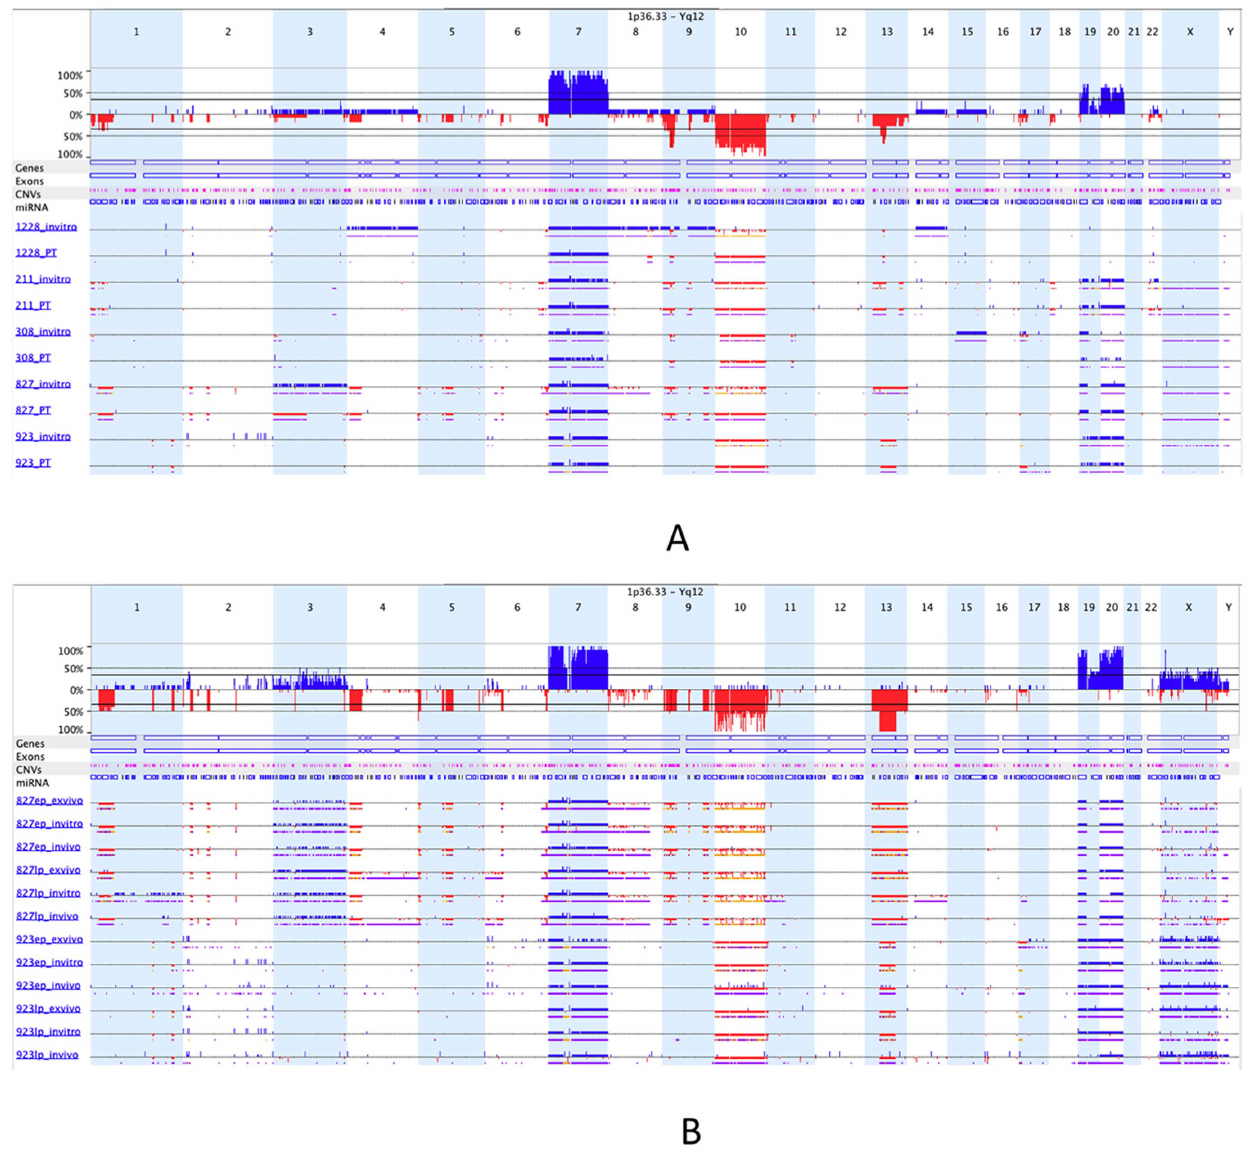
Figure 1. Copy number alterations for patient tumors and invitro , invivo , exvivo GSC samples. (A) Comparison of five matched patient tumors and their corresponding in vitro GSCs. Each line represents a sample. Three or four digit code represents GSC id, PT represents patient tumor and invitro represents in vitro GSC. Blue is amplification, red is deletion, purple is loss of heterozygosity and orange is allelic imbalance. Examples of the many differences between PTs and matched in vitro GSCs are loss on chromosome 13 at GSC-827 and gain on chromosomes 4, 8, 9 and 14 at GSC-1228. (B) Comparison of in vitro - in vivo - ex vivo triplicates for early and late passages of two GSCs.